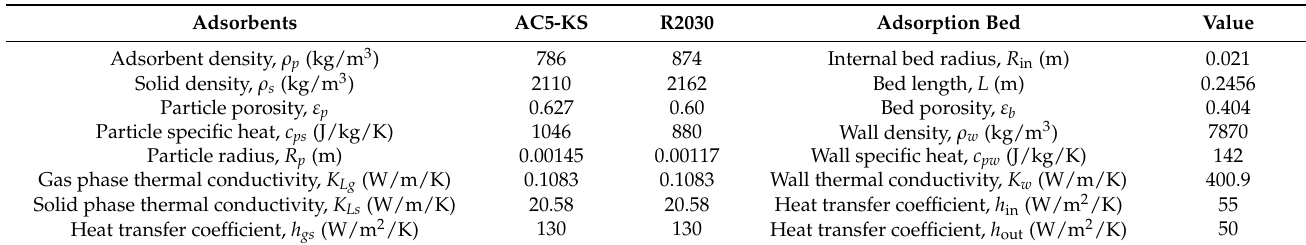
Table 2. Characteristics of adsorbents and adsorption bed [30,34].